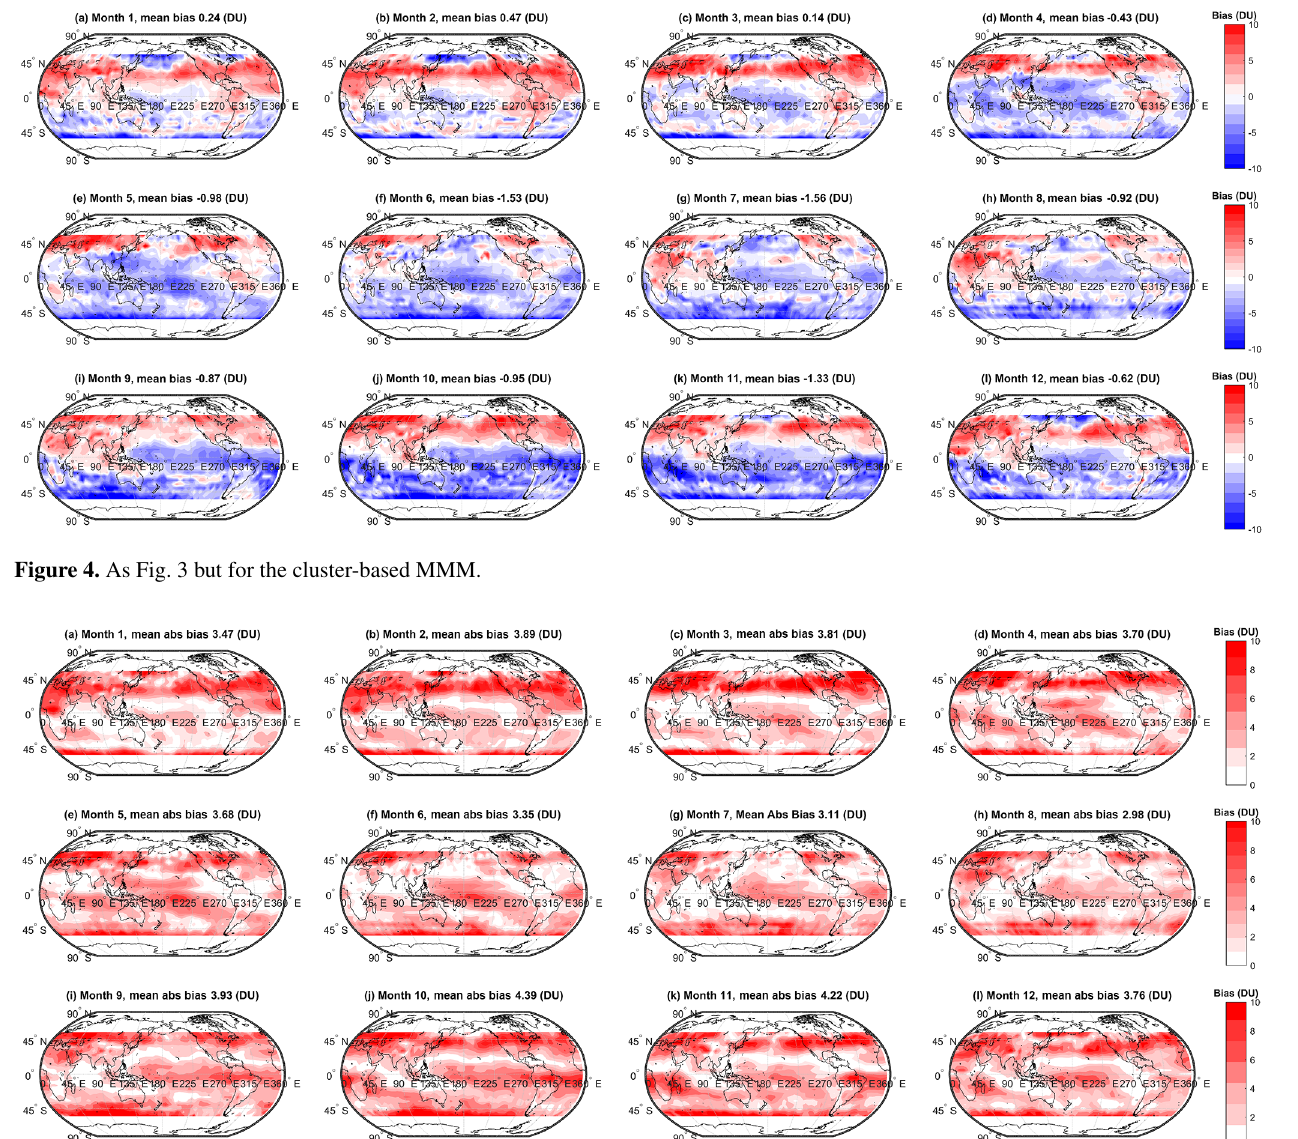
Figure 5. Monthly absolute bias (DU) between the simple arithmetic multi-model mean (MMM) tropospheric ozone column and the observed climatology. Global mean values are